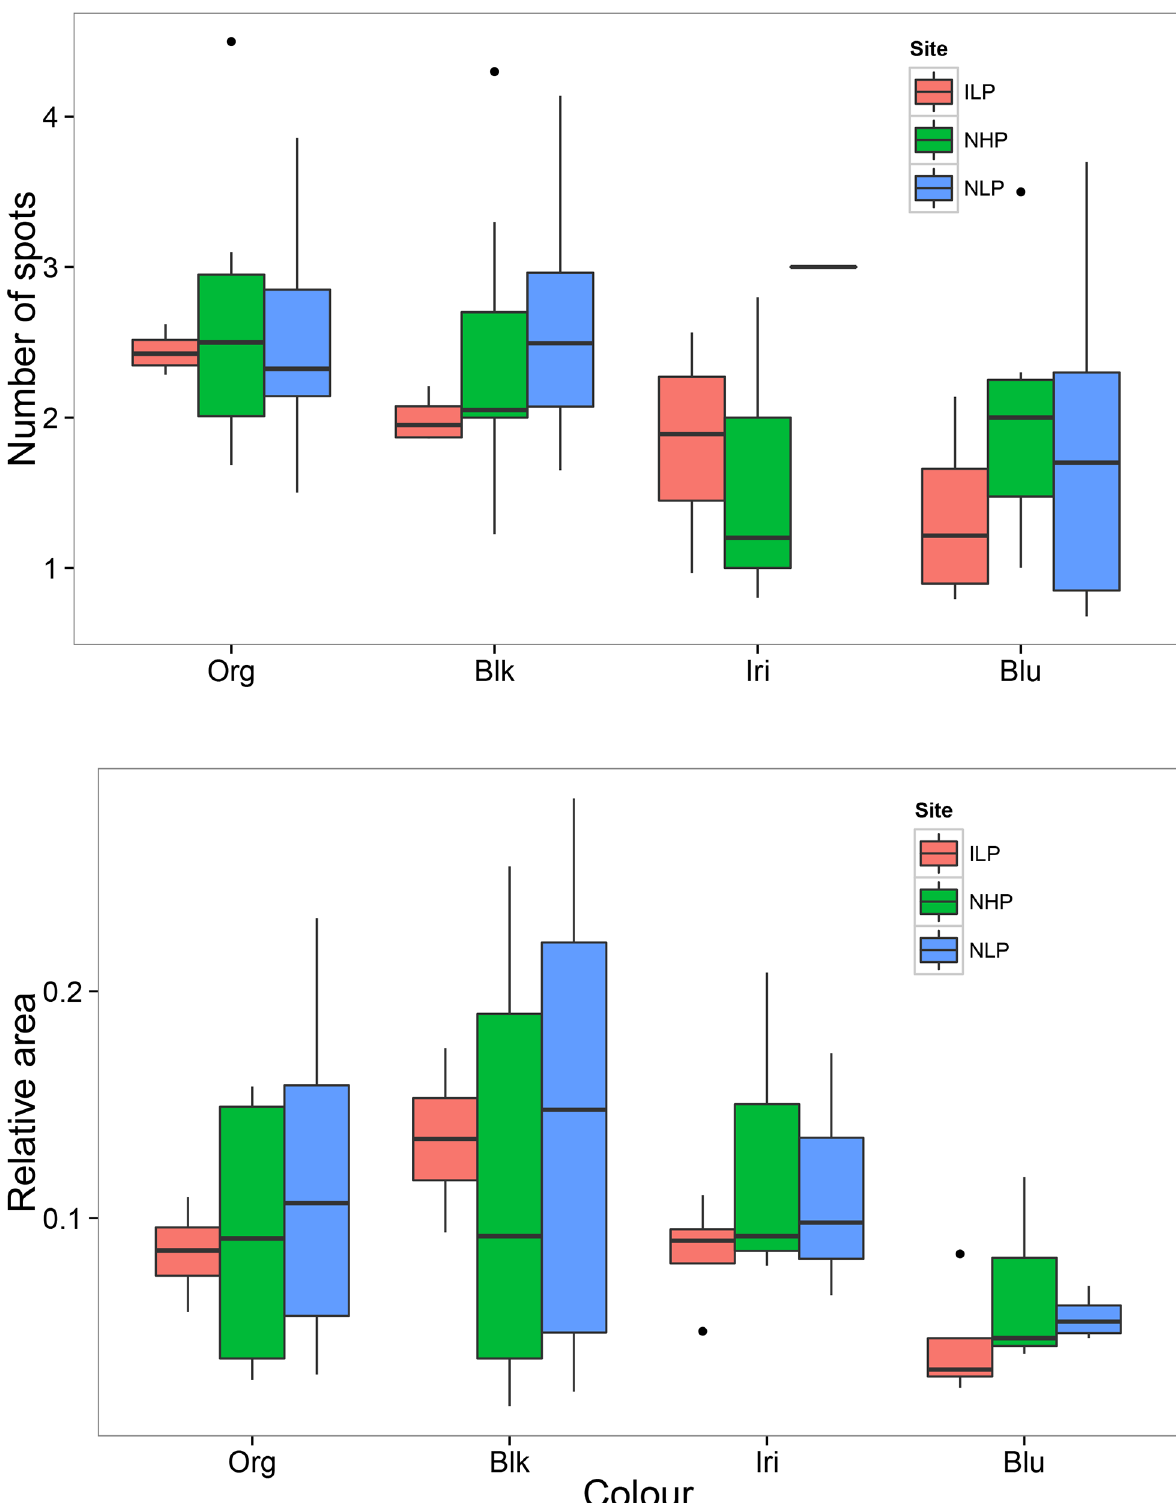
Fig 4. Color variation between native and introduced populations of P . reticulata . The data represent number of spots (top panel) and relative colour area (bottom panel) in introduced low predation populations (ILP), and native low (NLP) and high (NHP) predation populations. Boxes represent the interquartile range and the error bars represent the total range of the data. Data from native populations were obtained from the published literature (S2 Table).